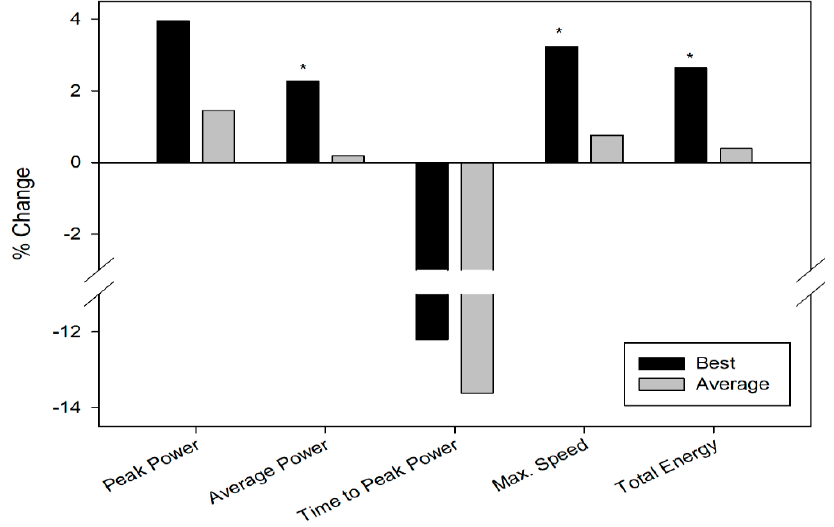
Figure 3. Changes in the repeated sprint test results after supplementation with Cardiose ® using best data of each of the four sprint tests and the average of all sprints. * = between-group significant changes ( p < 0.05).